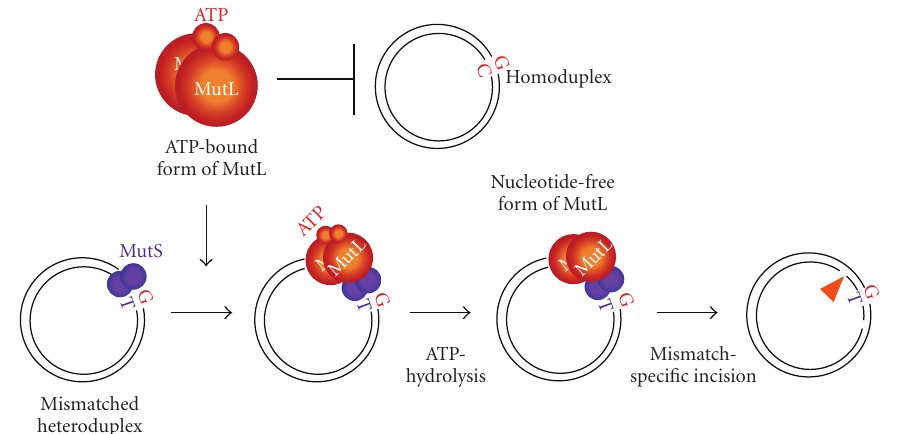
Figure 9: A model for the ATPase-cycle-dependent regulation of bacterial MutL endonuclease activity. Free MutL exists as an ATP-bound form whose endonuclease activity is inactive, but preferably binds to a MutS-mismatch complex. The interaction with the MutS-mismatch complex induces the ATP hydrolysis of MutL, resulting in the stimulation of its endonuclease activity. Adapted from the work of Fukui et al. [34].